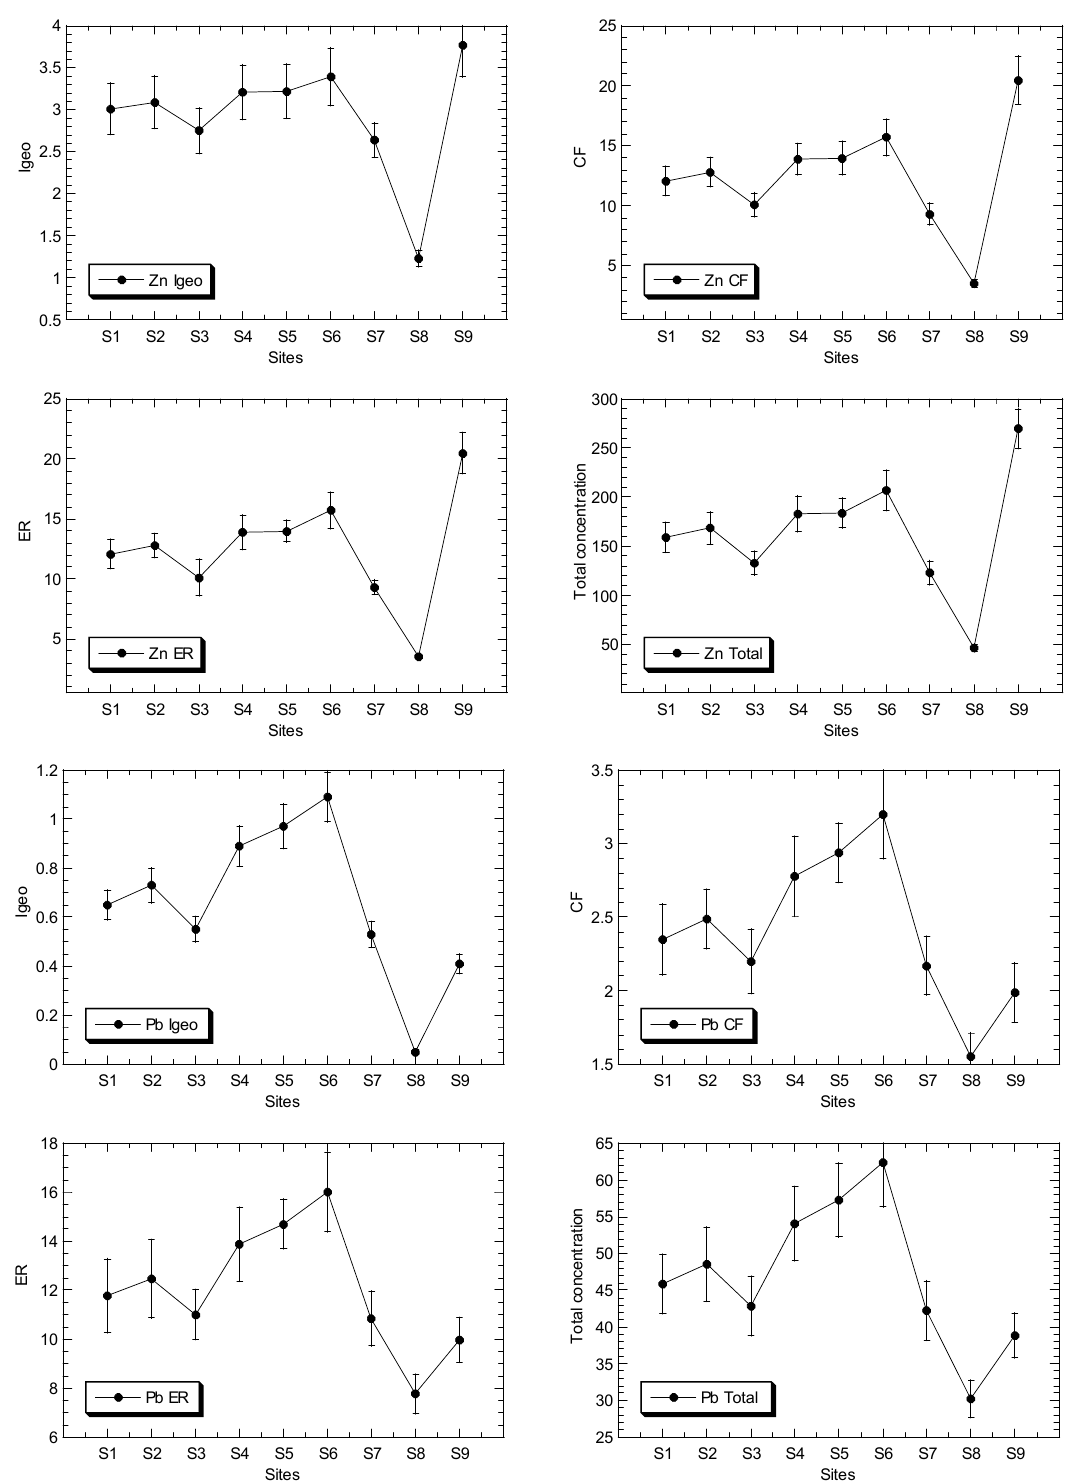
Figure 2. Total concentrations (mean ± standard error, mg/kg dry weight), values of geoaccumulation index (I geo ), contamination factor (CF), and ecological risk (ER) for Cu, Ni, Pb and Zn, of surface sediments in Klang mangrove ecosystem (S1–S8) and Juru mangrove (S9), based on background concentrations (mg/kg dry weight) of the metals that were reported from Peninsular Malaysia, namely: 9.48, 3.55, 7.31, and 13.16 for Pb [40], Cu [41], Ni [42], and Zn [43],